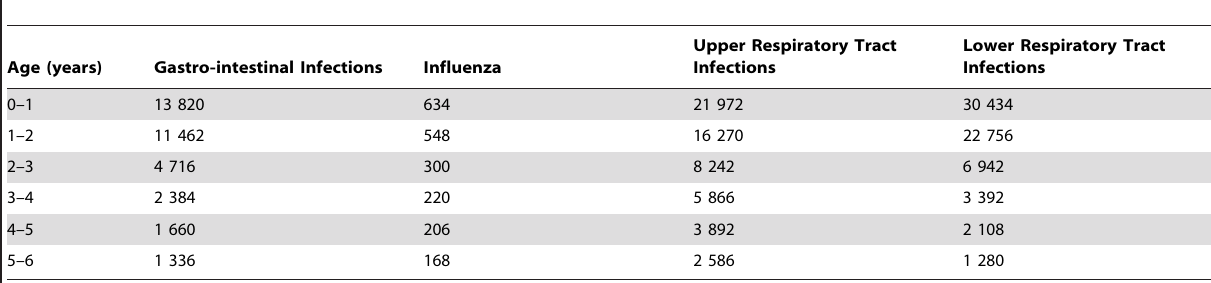
Table 1. Number of hospitalizations in 394,170 children during 2,330,174 person-years by age.